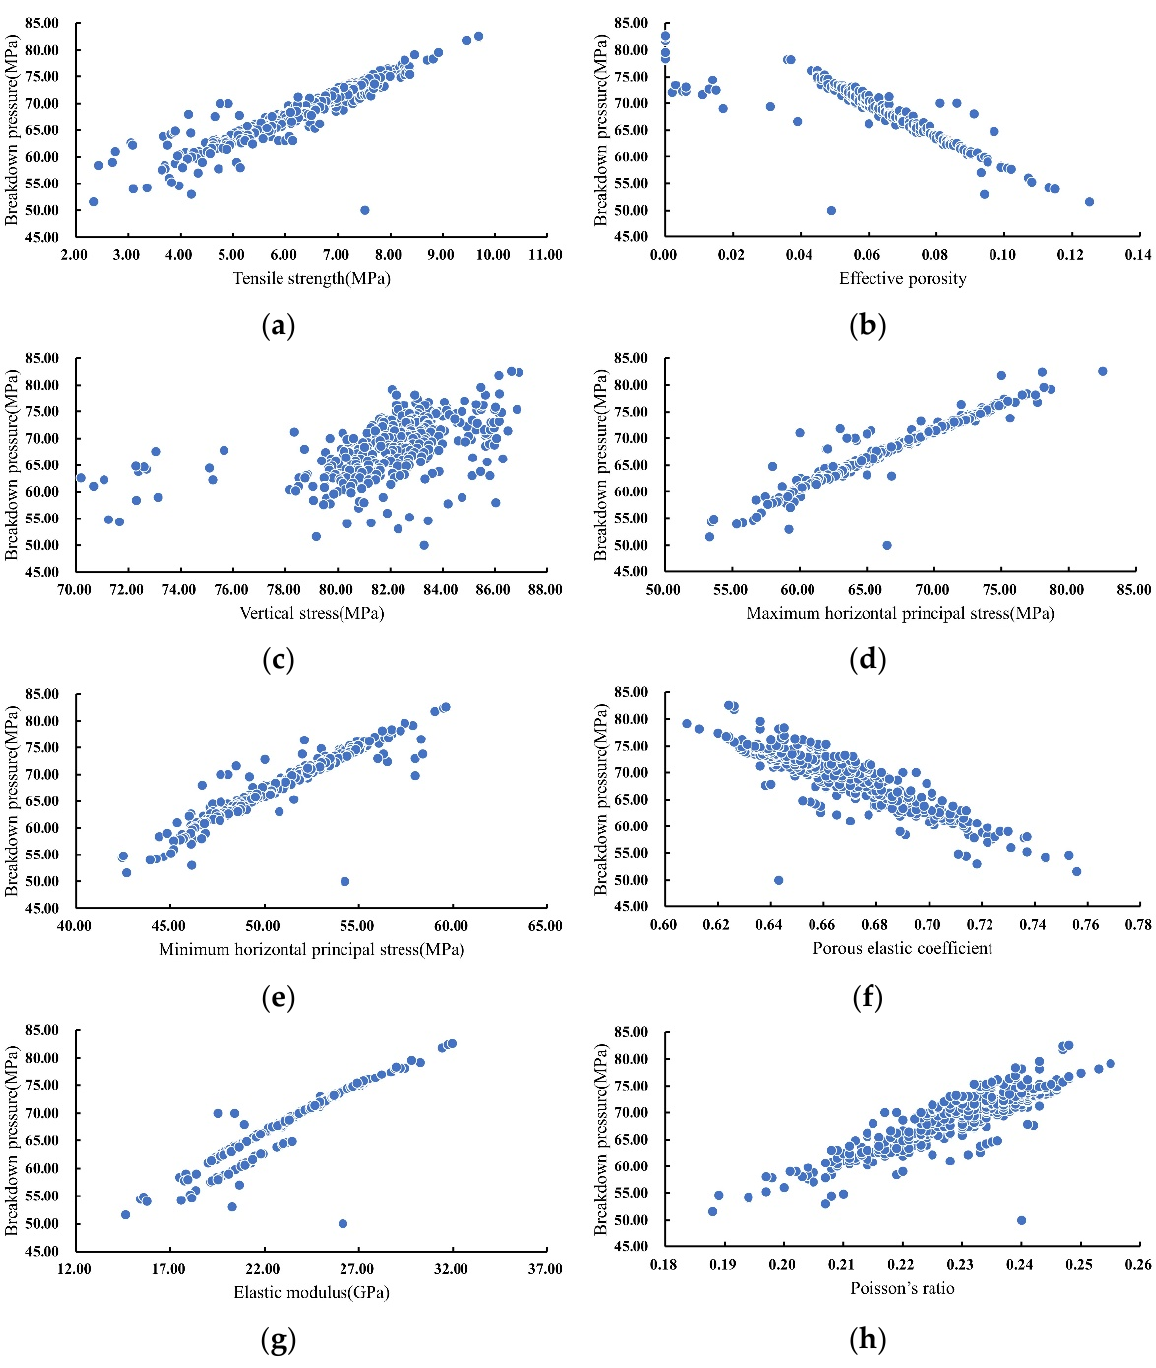
Figure 7. Scatter diagram of correlations between the influential factors regarding open hole completion breakdown pressure. ( a ) Tensile strength–breakdown pressure. ( b ) Effective porosity–breakdown pressure. ( c ) Vertical stress–breakdown pressure. ( d ) Maximum horizontal principal stress–breakdown pressure. ( e ) Minimum horizontal principal stress–breakdown pressure. ( f ) Porous elastic coefficient–breakdown pressure. ( g ) Elastic modulus–breakdown pressure. ( h ) Poisson’s ratio–breakdown pressure.